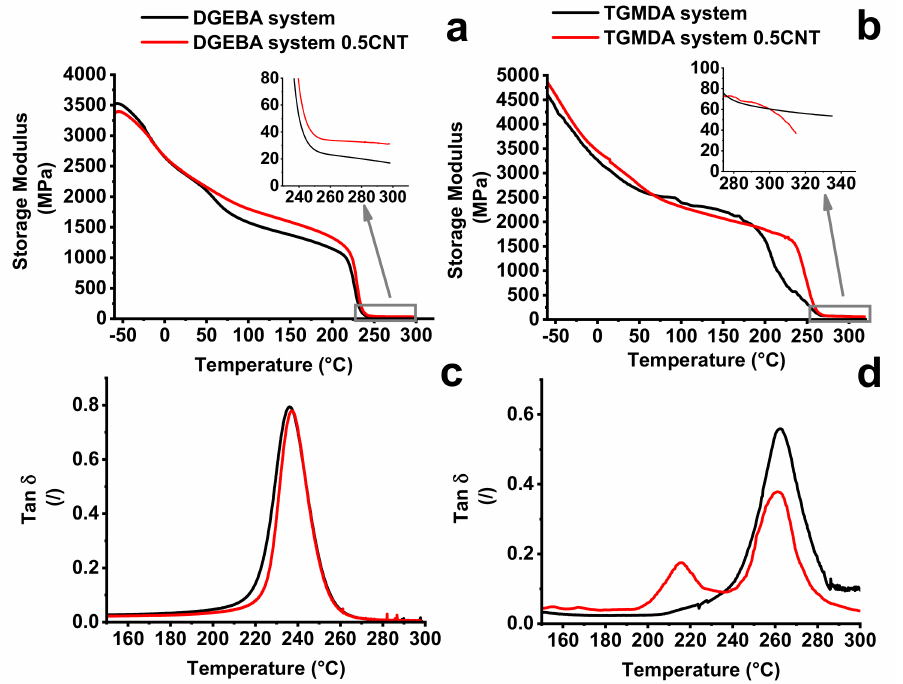
Figure 7. DMA results of the two systems: ( a ) curves of storage modulus of the unfilled and filled (0.50% wt/wt of CNTs) DGEBA system; ( b ) curves of storage modulus of the unfilled and filled (0.50% wt/wt of CNTs) TGMDA system; ( c ) Tan δ of the unfilled and filled DGEBA system; ( d ) Tan δ of the unfilled and filled TGMDA